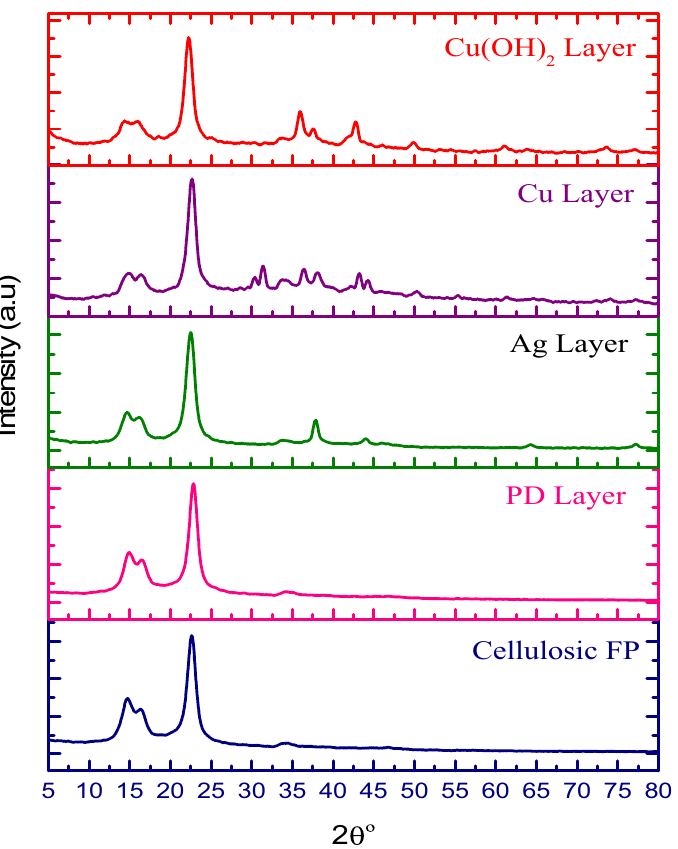
Figure 2. XRD patterns of cellulosic filter paper modified with different